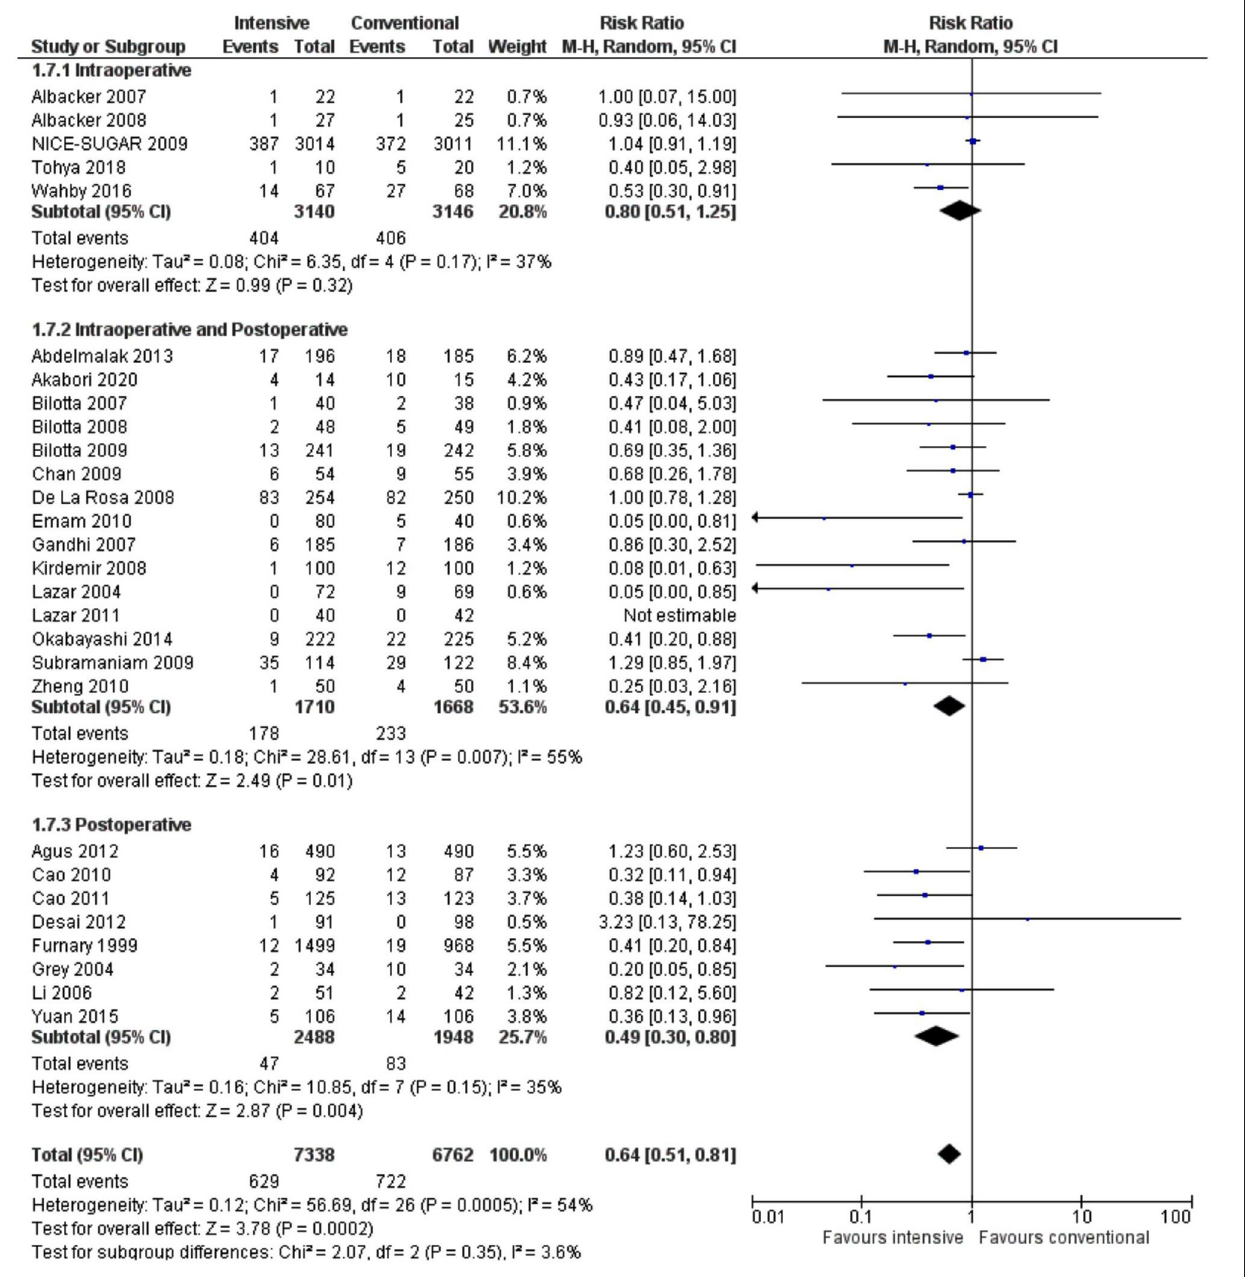
FIGURE 7 | A forest plot for a subgroup analysis according to timing of insulin administration in studies using a random-effects model. RRs and 95% CIs are